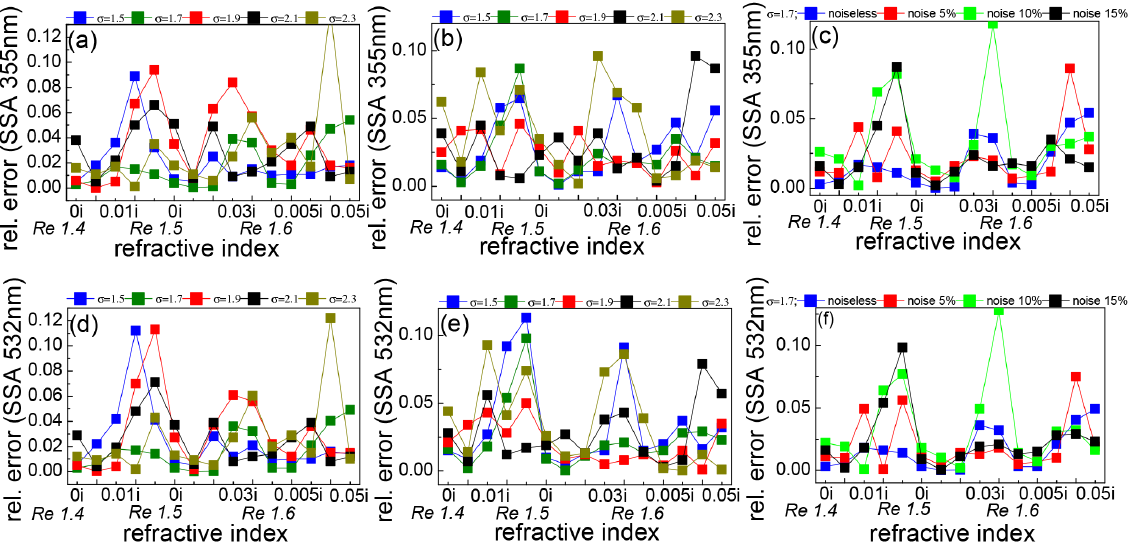
Figure 10. Relative error of the retrieval results for the SSA 355nm (first row) and SSA 532nm (second row). The first column corresponds to noiseless and second to 15% noisy input data. The last column shows the relative retrieval error with increasing noise level of the input data: 0, 5, 10, 15% for gsd 1.7 as an example. Each subfigure (a) – (f) is compartmentalized into three partitions with respect to the horizontal axis (refractive index). The partitions correspond to different real parts of CRI, namely 1.4, 1.5, and 1.6. Each partition shows the result for different imaginary parts of the CRI: 0, 0.005, 0.01, 0.03, 0.05 i